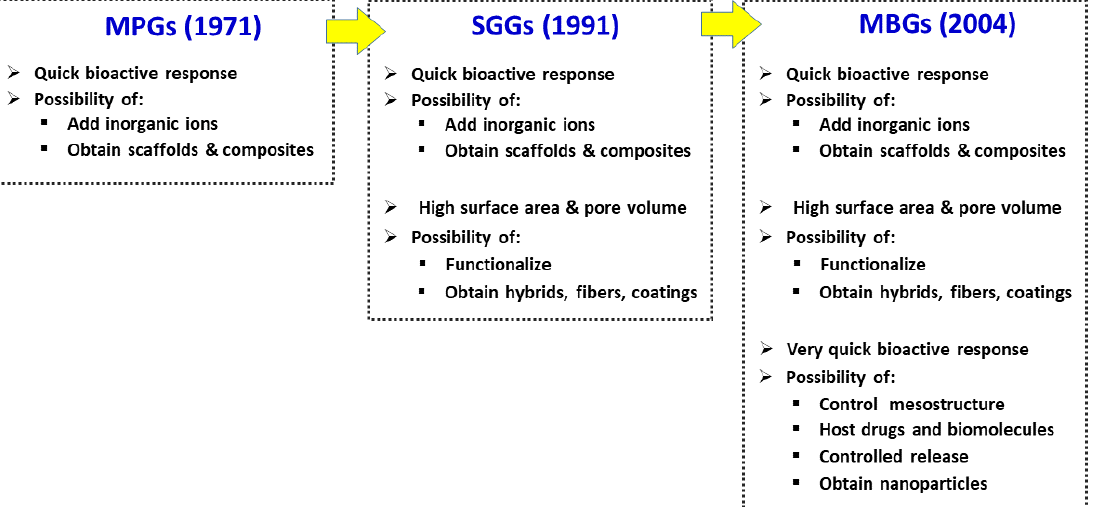
5 of 20 Figure 2. Textural properties of the three families of bioactive glasses. Transmission Electron Micro- graphs of the porous SGG and MBG are also included. Figure 3 shows how the timeline development of the new families of BG has im- proved their properties for use in bone regeneration. MPG are excellent biomaterials for